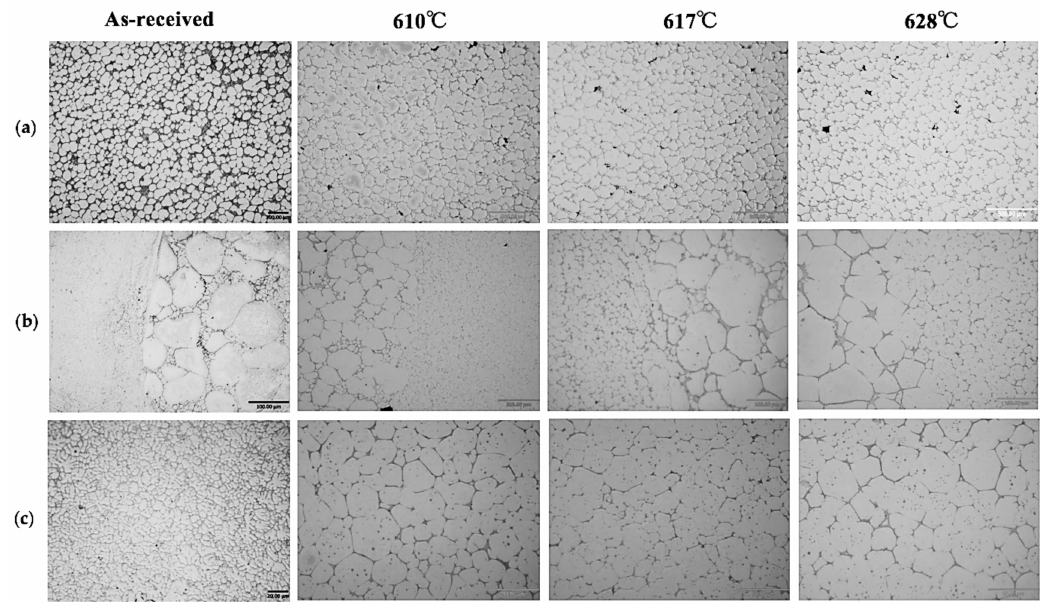
Figure 8. Optical microscopy micrographs of Al 7075 alloy EB welded plates after heat treatment at three temperatures: 610, 617 and 628 ◦ C. ( a ) as received plate material, ( b ) HAZ and plate boundary and ( c ) FZ weld area. (Magnifications top from left to right in µ m: 200, 500, 500, 500); (magnifications middle from left to right in µ m: 100, 200, 100, 100); (magnifications bottom from left to right in µ m: 20, 50, 50,